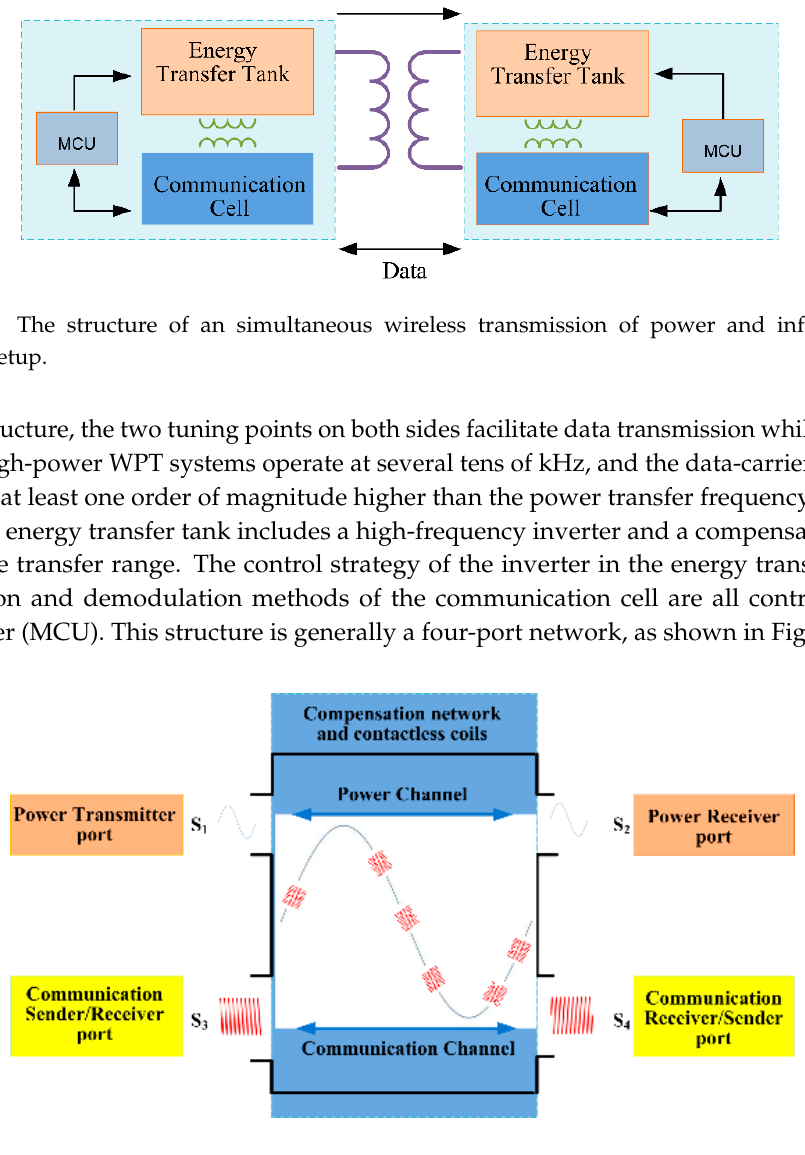
Figure 2. Four-port network diagram for SWTPI.